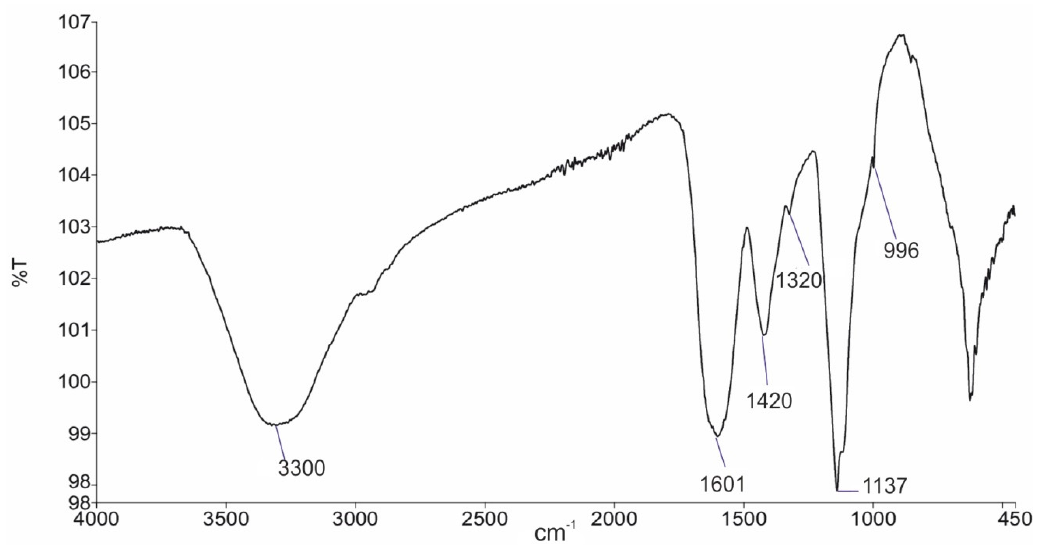
Figure 1. FTIR spectrum of the synthesized carbon nanodots of Dunaliella salina (CNDs-DS).